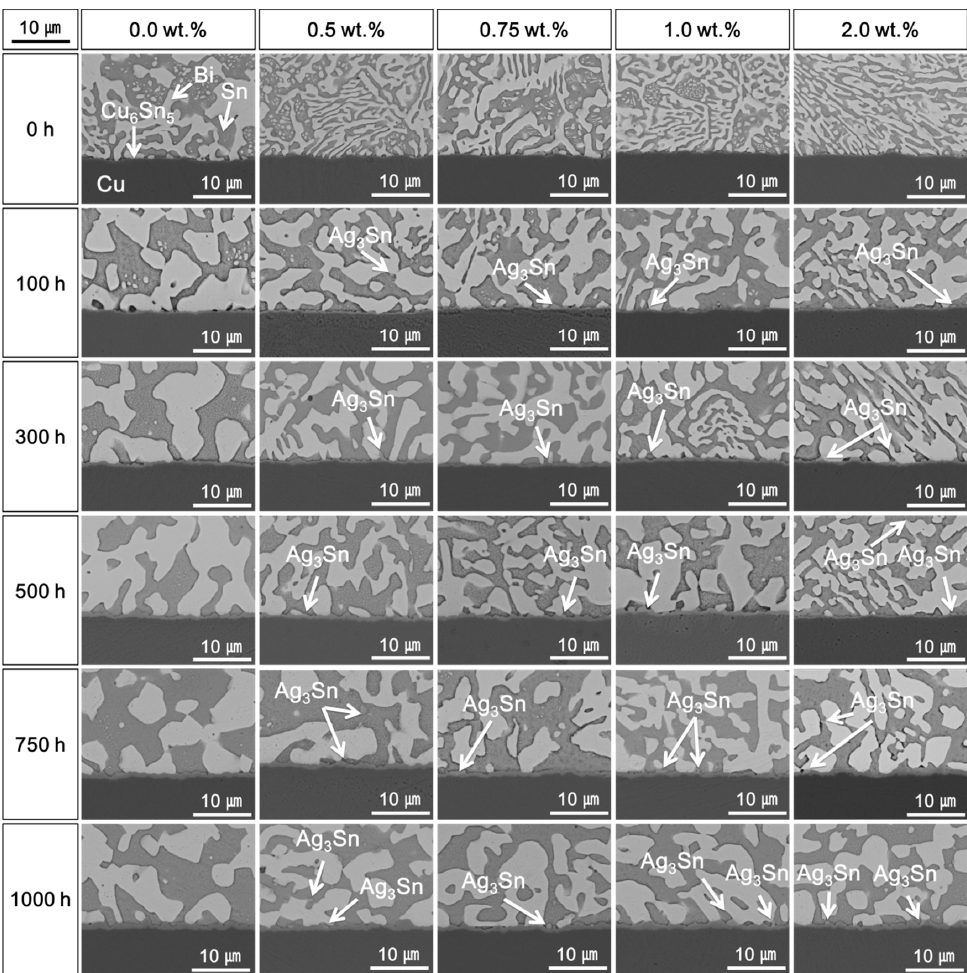
Figure 2. Cross-sectional scanning electron microscopy (SEM) micrographs of the Sn–58Bi Ag NP composite solder joints after high-temperature storage (HTS) tests at 85 °C .